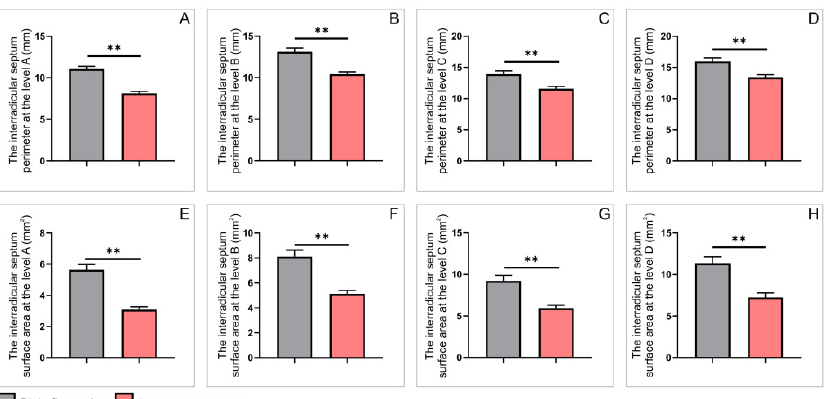
Figure 7. The parameters obtained on axial slices for upper molars on the right side: ( A – D ) the interradicular septum perimeter (in mm) at the levels A–D, respectively; ( E – H ) the interradicular septum surface area (in mm 2 ) at the levels A–D, respectively. Values are expressed as the mean ± SEM. ** Denotes a significant difference, p < 0.01.